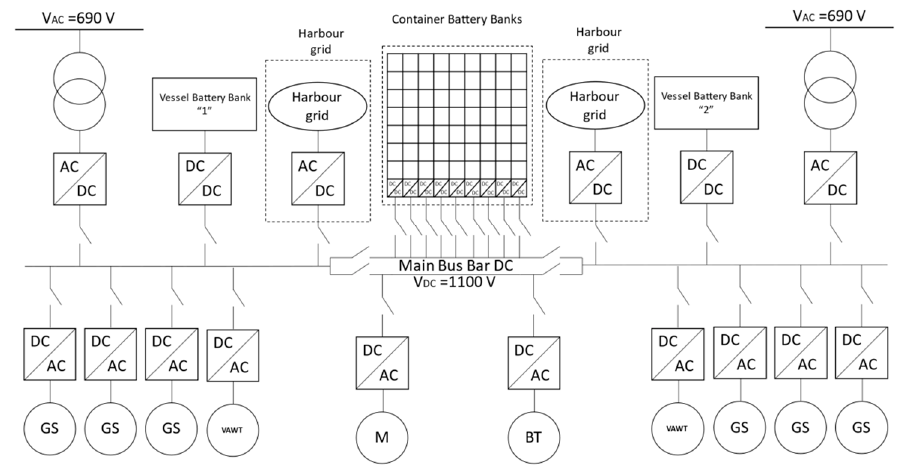
Figure 2. The cargo vessel grid topology. The first number after the name “Container battery bank” indicates the order number of the battery stack. The second number indicates the order number of the bank in the container stack. Additionally, Figure 2 indicates DC lines for each of the vessel battery banks and container stacks of battery banks. Figure 2 contains the AC lines for the needs of the vessel battery bank and container battery banks. As can be seen, the system is symmetrical and redundant with the possibility of switching between power